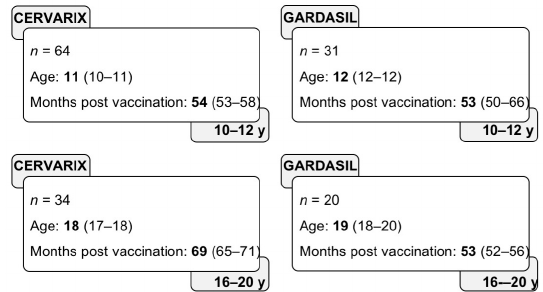
Figure 1. Study groups. For each age and vaccine group, the number of subjects, their median age (with interquartile range), and the time of sample collection after the third immunization (presented as median and interquartile range) are shown.